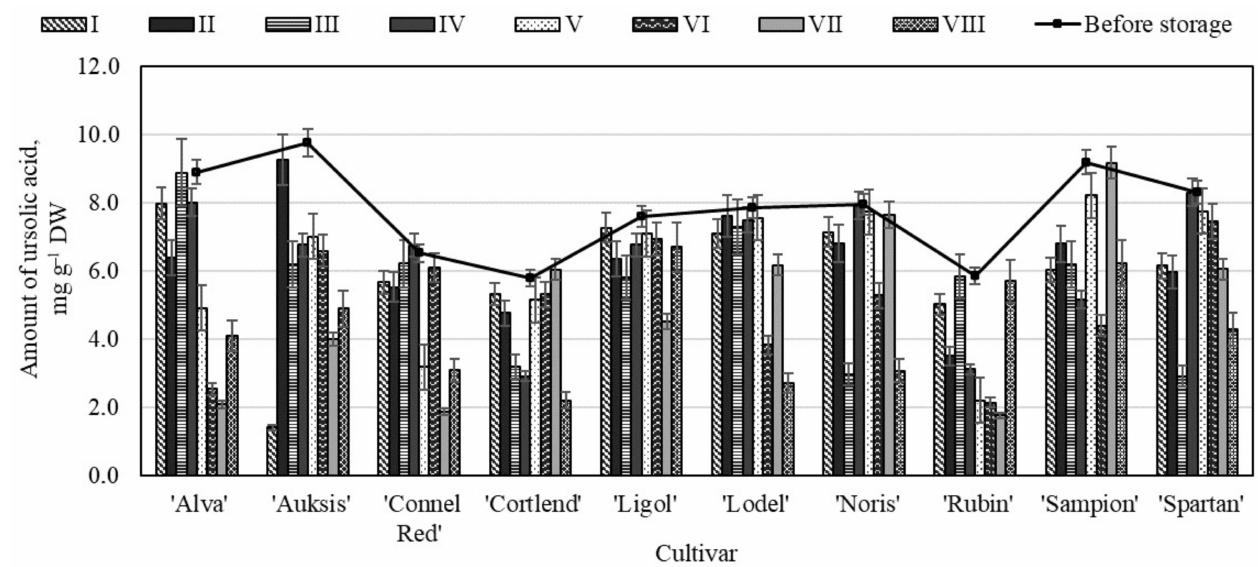
Figure 7. Changes in the amount of ursolic acid in the apple peel samples before and after storage in